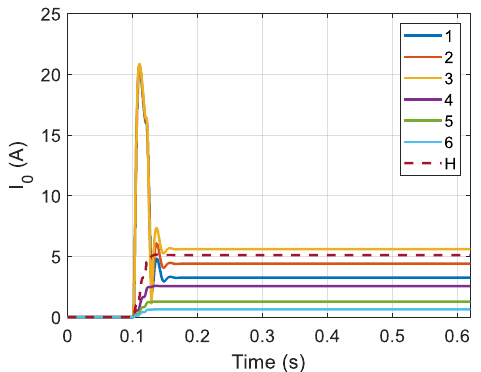
Figure 12. Zero sequence current magnitude.